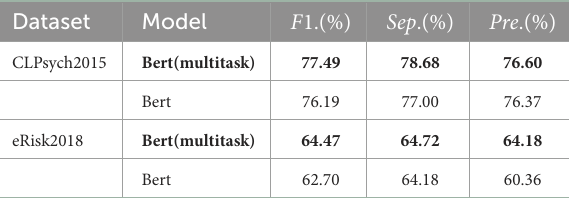
TABLE 7 F 1. represents F1 score, Sep . represents specificity, and Pre . represents precision. Dataset